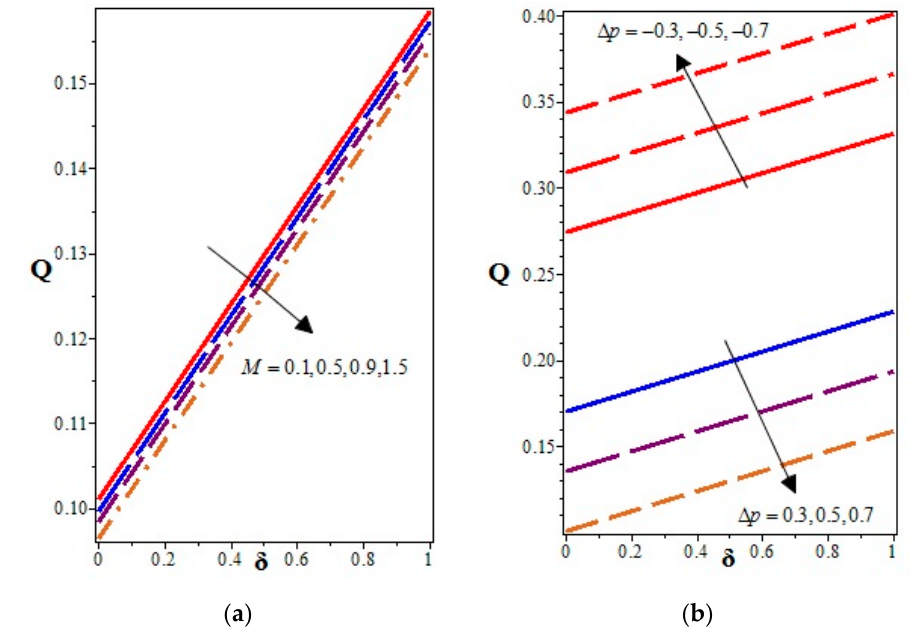
δ for different values of: ( a )